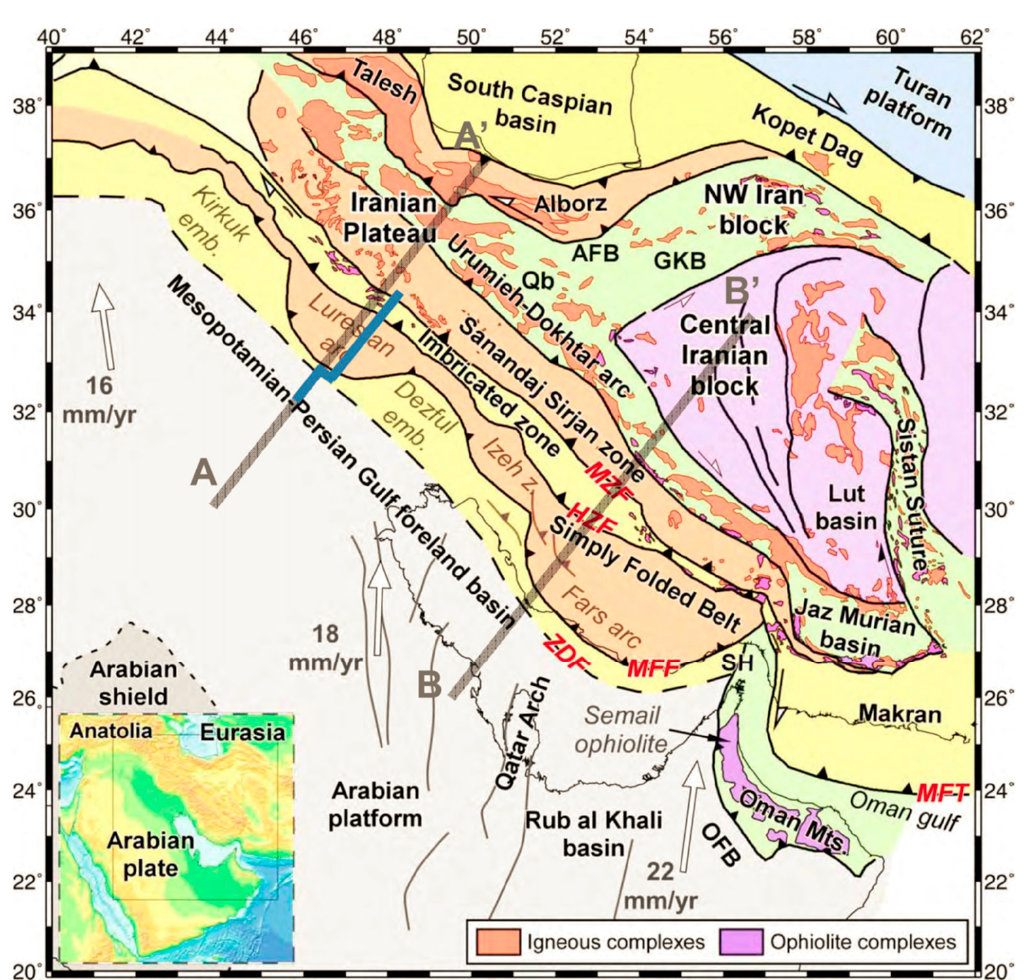
Figure 2. Geological cross section along the line X-X (See Figure 1). The X-X line is also parallel with the axis of the Kuh-e-Mond anticlinal structure. The location of wells especially wells MD-1 to MD-8 is presented here. Drilling of MD-8 which is the last appraisal well drilled in the field is benefited from the studies reported in this paper over the past decade. In addition, the cores and the image logs all belong to MD-8.